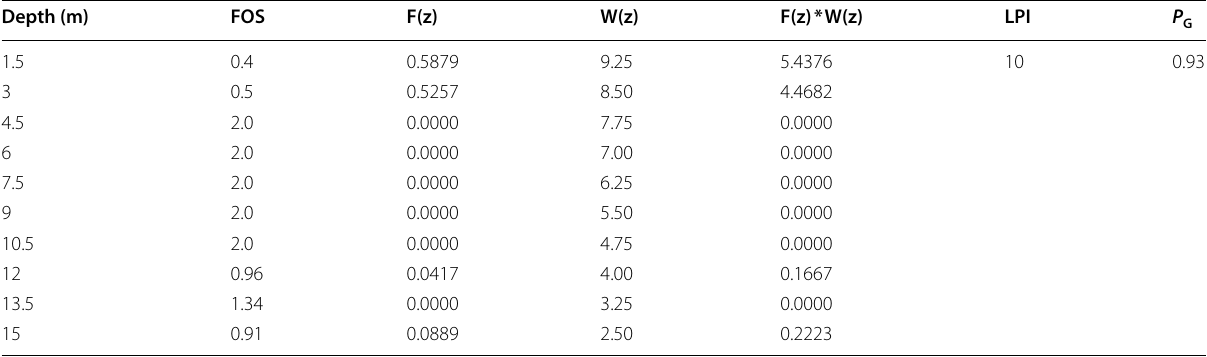
Table 2 Calculation of FOS-based liquefaction potential index (LPI) using Iwasaki et al. (1982) and probability of ground failure ( P using Li et al. (2006) at Babarmahal (27° 41 ′ 39 ″ N, 85° 19 ′ 28 ″ ) Depth